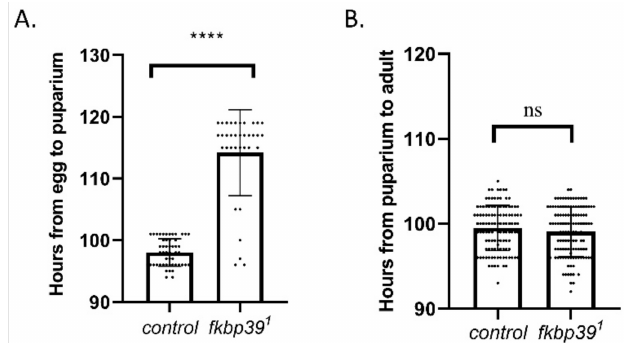
Figure 4. FKBP39 controls Drosophila development. ( A ) The developmental time from egg to puparium in wild type or fkbp39 1 . ( B ) The developmental time from puparium to adult in wild type or fkbp39 1 . Error bars represent the S.D. of indicated values. **** p < 0.0001; ns, not significant.